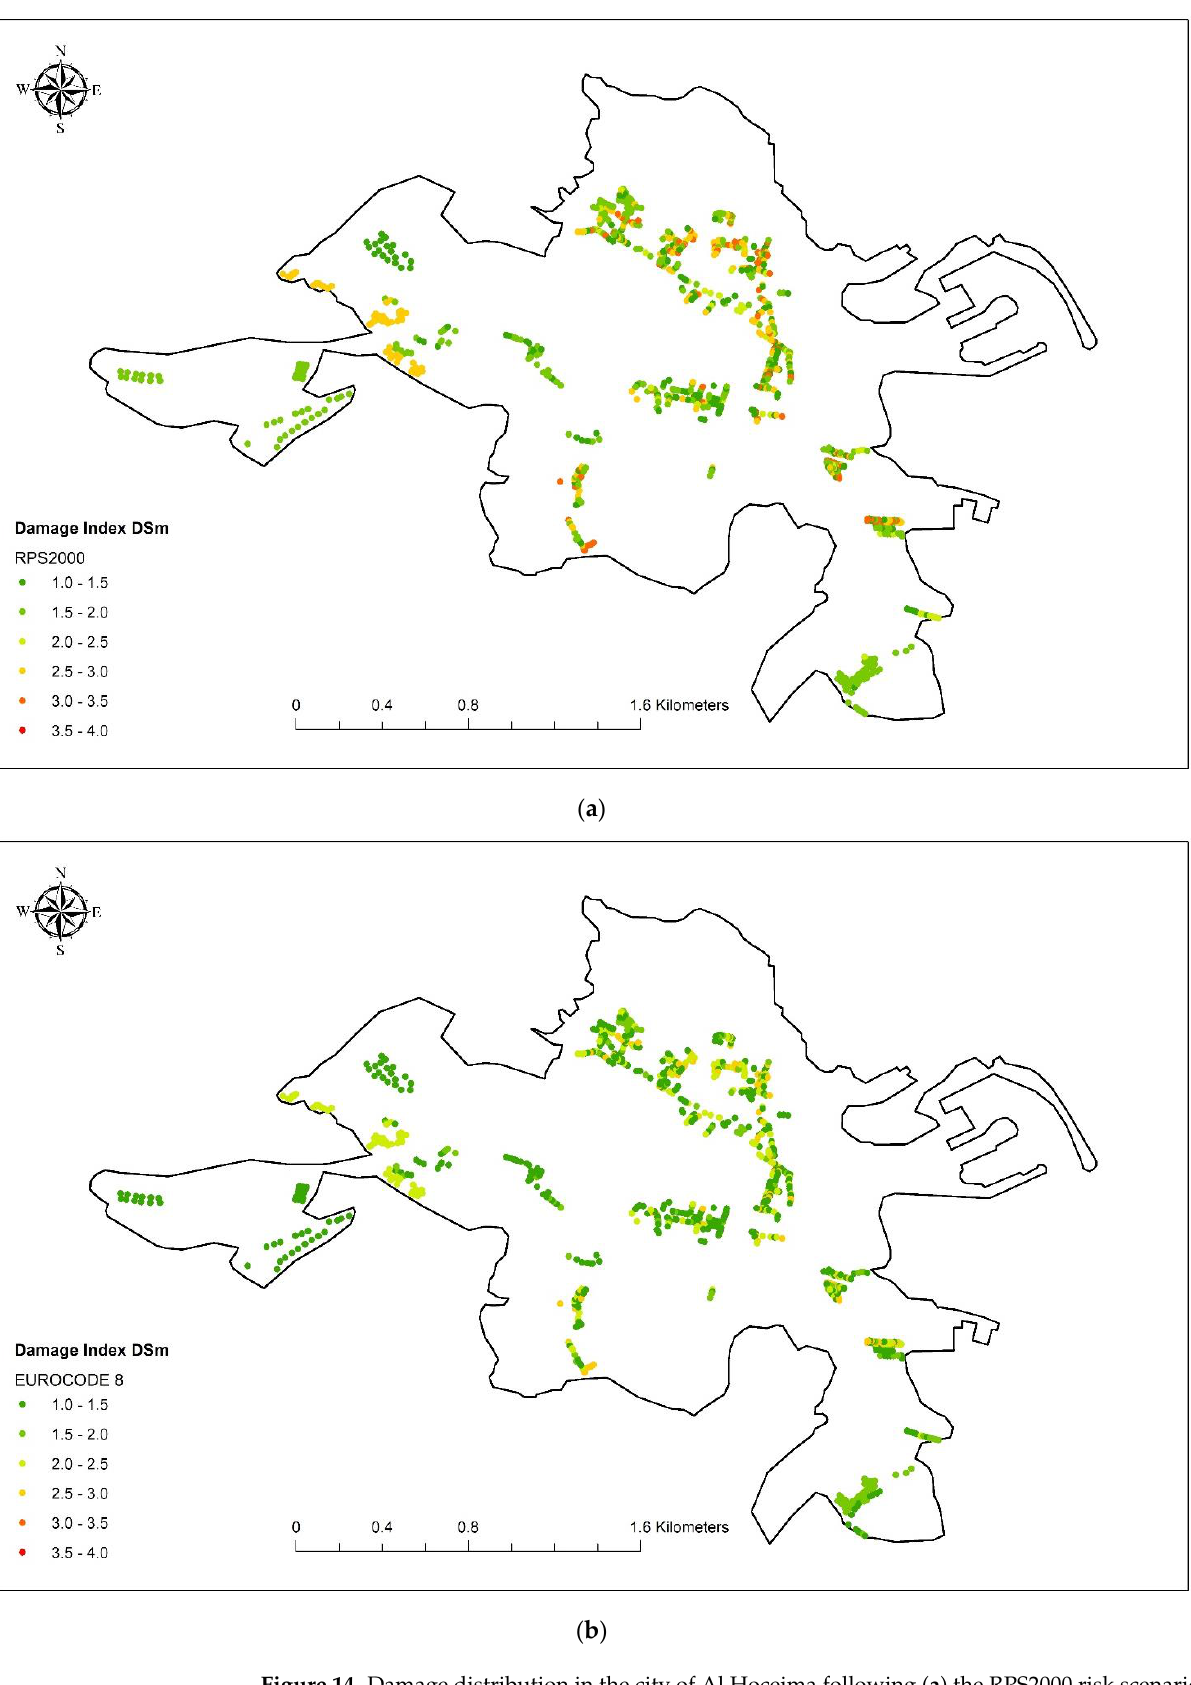
Figure 14. Damage distribution in the city of Al Hoceima following ( a ) the RPS2000 risk scenario and ( b ) the Eurocode 8 risk scenario.